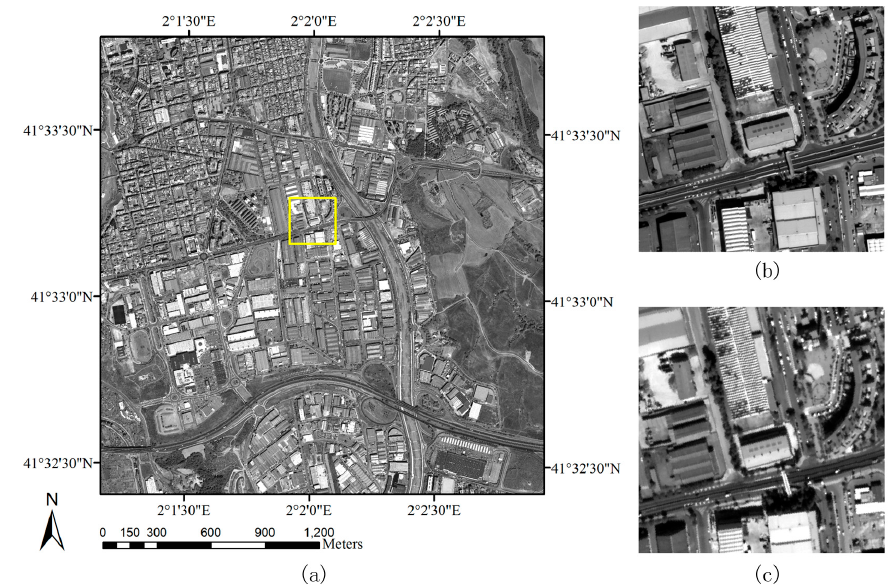
Figure 9. Images of stereo pair 2. Descriptions of the content are the same as those in Figure 8. ( a ) Image 1 of the stereo pair as a whole. ( b , c ) A detail view of the yellow rectangle seen in ( a ) in Image 1 and in Image 2, respectively.